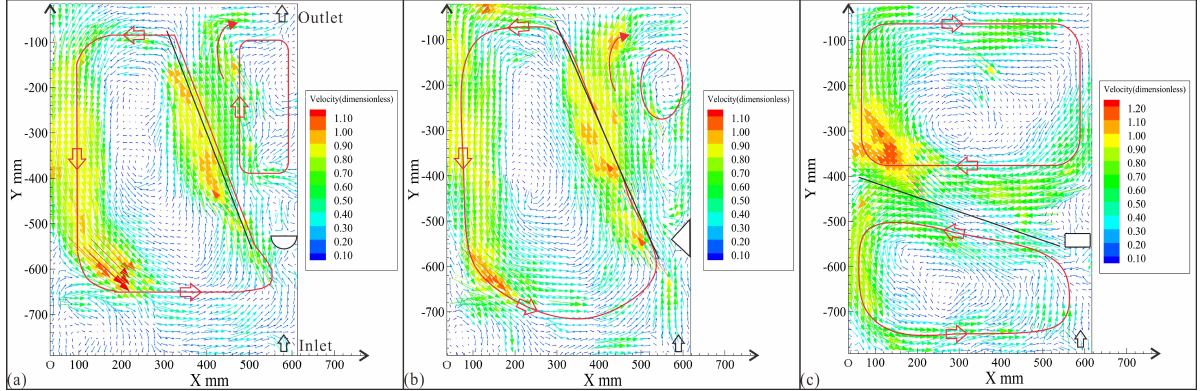
Figure 7. Straight line of the mainstream center (black line): ( a ) semi-cylinder, Q = 6.8 L/min, l = 0.31; ( b ) triangular prism, Q = 6.8 L/min, l = 0.31; ( c ) rectangular column, Q = 6.8 L/min, l = 0.31.